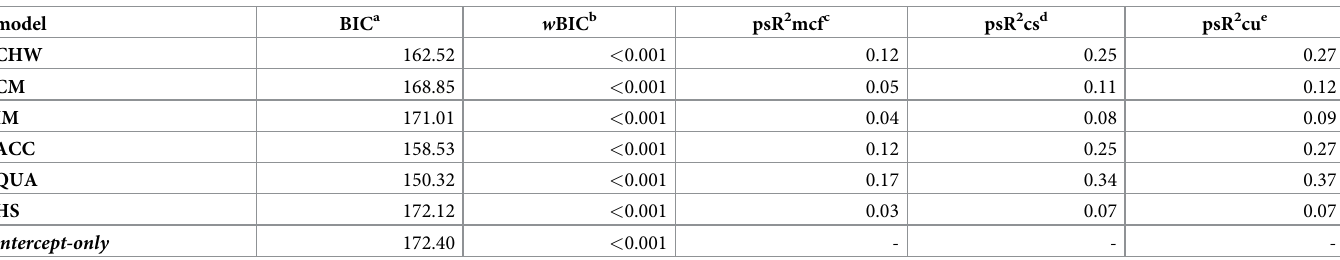
S1 Fig. Regionalization map. World map showing four regional classes used as a random effect in the general linear mixed-effects models ( n = 64 countries). Country codes per region (3-letter ISO): Latin America & Caribbean (COL, DOM, GTM, HTI, HND, PER); Sub-Saha-